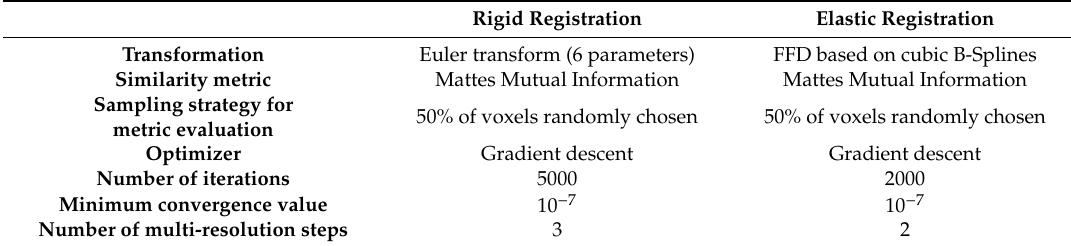
Table 1. Parameters chosen for the rigid and elastic image